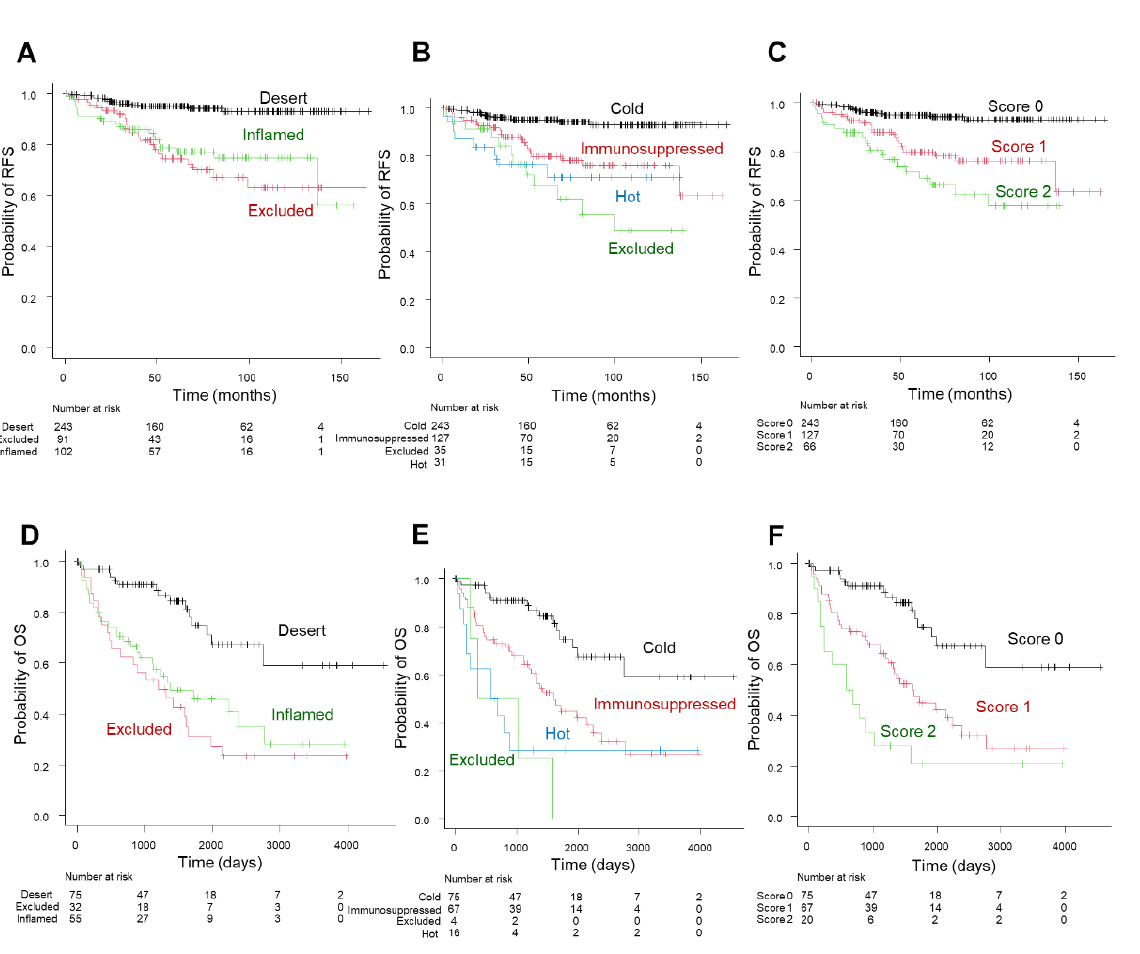
Figure 6. Prognostic significance of the three-tier and four-tier immunophenotype and inflammation score in the principal cohort ( A – C ) and TCGA cohort ( D – F ). Kaplan–Meier curve of recurrence-free survival (RFS) in the three-tier immunophenotype ( A ); four-tier immunophenotype ( B ); and inflammation score ( C ). Kaplan–Meier curve of overall survival (OS) in three-tier immunophenotype ( D ); four-tier immunophenotype ( E ); and inflammation score ( F ).